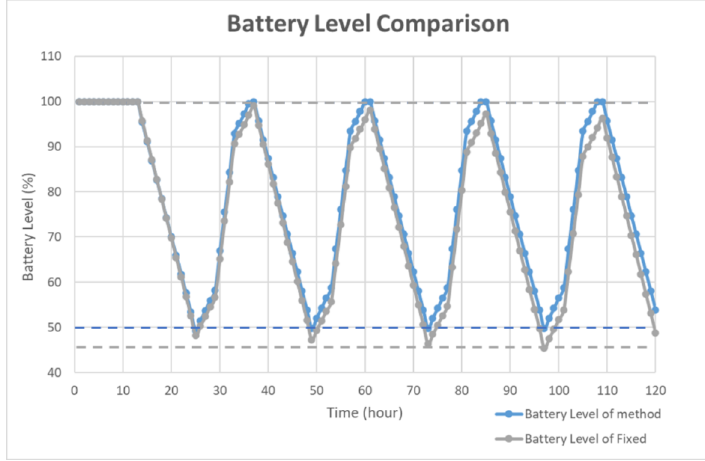
Figure 7. Battery level comparison of the proposed method and static